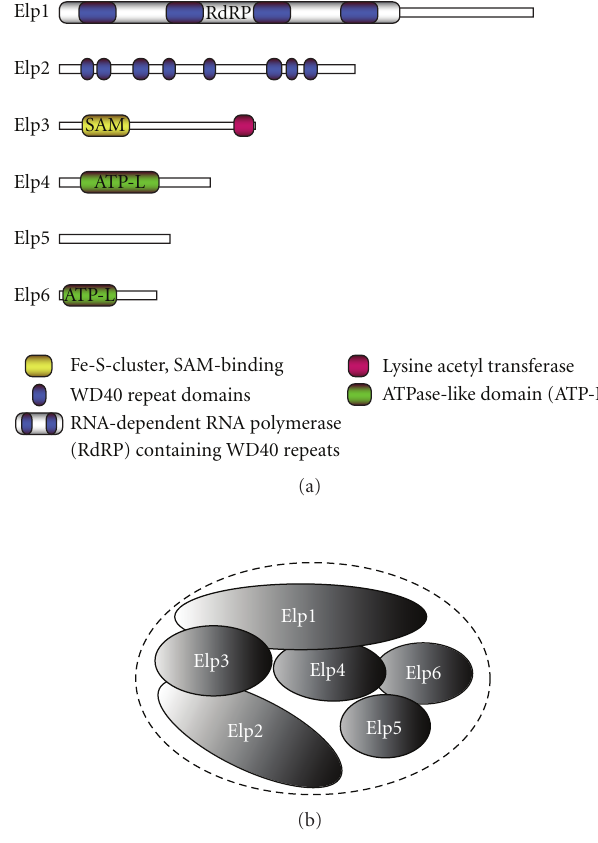
Figure 1: The Elongator complex and its components. (a) Schematic view of the Elp proteins and their domain structure. (b) Current model for the architecture of the Elongator